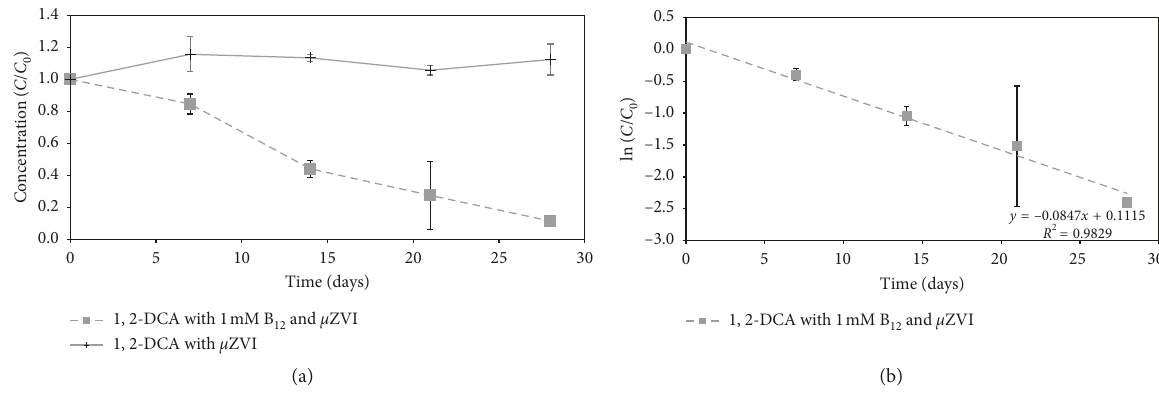
Figure 5: (a) Degradation of 1,2-DCA (13.52mg/l); (b) degradation rate of 1,2-DCA.